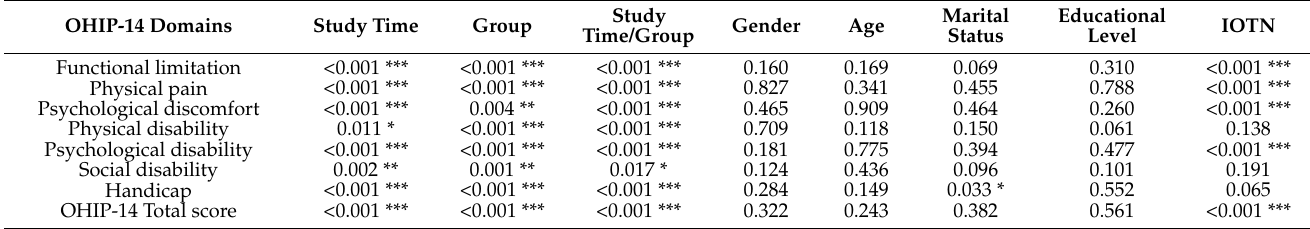
Table 5. Effects of groups, study times, and patient-related variables on OHIP-14 domains. Multiple regression models with generalized estimation equations (GEE)